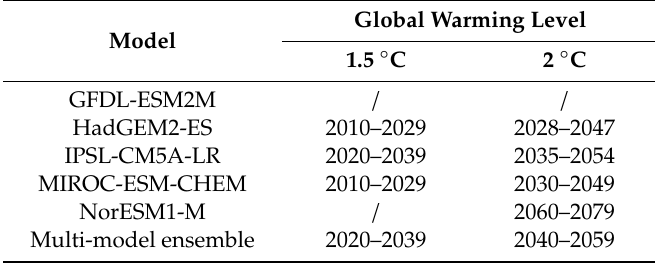
Table 3. The timings of 1.5 ◦ C and 2 ◦ C global warming simulated by five models and their